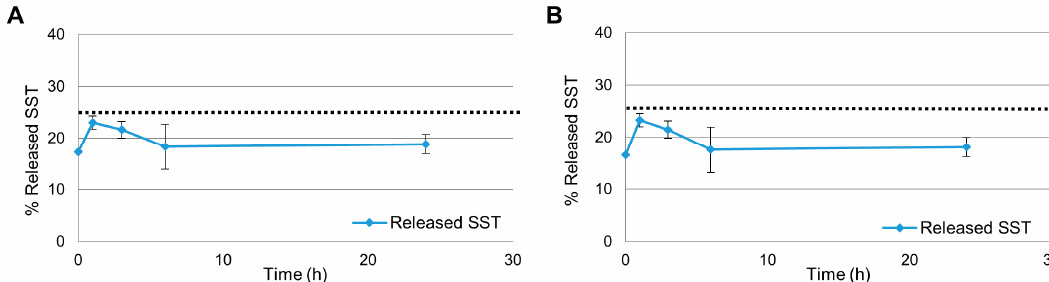
Figure 4. Released SST from the NEs following protocol 2. ( A ) Considering as 100% the sum of the fraction released, the fraction still encapsulated and the non-encapsulated one at each time point. ( B ) Considering as 100% the amount of SST expected in the samples from the centrifugation step. The dotted line represents 25%, the amount of SST available after the centrifugation to remove the non-encapsulated fraction of SST.